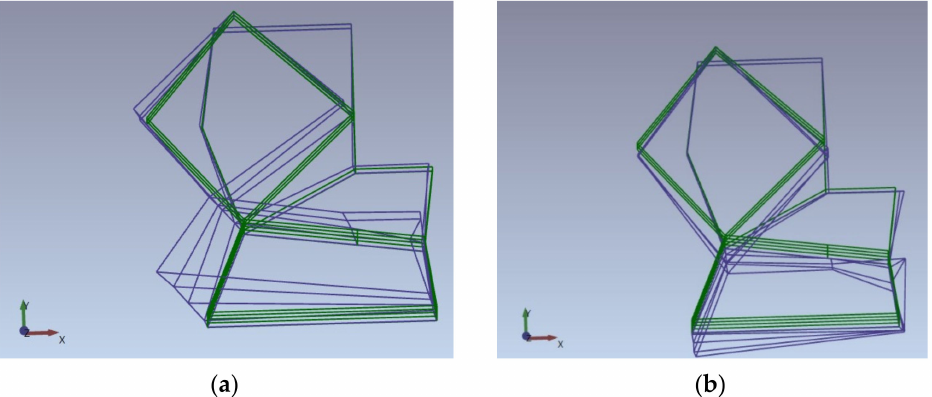
Figure 14. Experimental mode shapes identified for Test 1.a (without sensors placed at nodes 46, 38, 30, 22) plan views (in green the un-deformed configuration and in blue the mode shape): ( a ) second mode (bending along x axis); ( b ) third mode (bending along y axis).